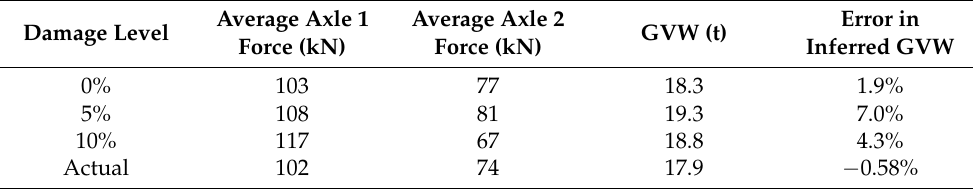
Table 3. Average axle force for different levels of